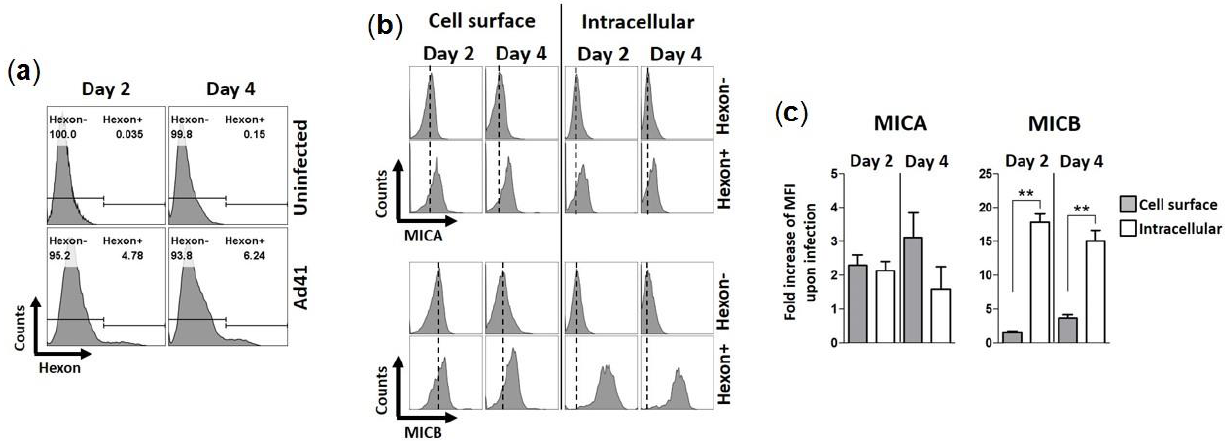
Figure 4. Expression of MIC ligands in HAdV-F41-infected HCT116 cells. HCT116 cells were infected with HAdV-F41 (MOI 0.5) and levels of MIC A and MIC B were assessed on the cell surface and intracellularly by flow cytometry, on day 2 and 4 post-infection. ( a ) Flow cytometry histograms showing staining of HAd41-infected cells (Hexon + ) using a 2Hx-2 monoclonal anti-hexon Ab [34] with further detection with a secondary anti-mouse-FITC Ab. ( b ) Flow cytometry histogram showing expression levels of MIC A and MIC B on the cell surface and intracellularly. Hexon - populations were gated from uninfected samples. Dashed lines represent the MFI levels of MIC A or MIC B on uninfected samples. ( c ) Fold increases in expression of MIC A and MIC B upon HAdV-F41 infection were calculated as MFI hexon+ / MFI hexon- . ** p < 0.01 defined by t student test.